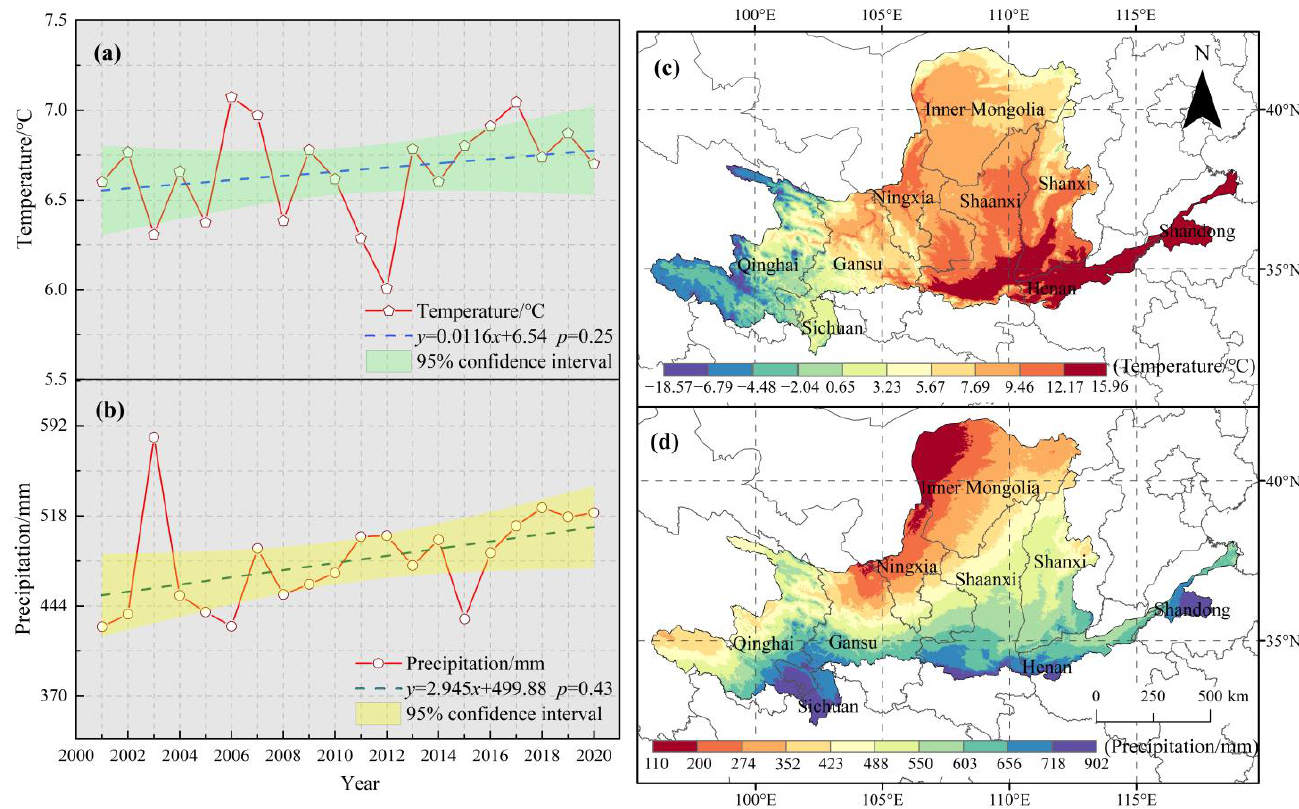
Figure 7. Trends and spatial distribution of temperature and precipitation in the YRB from 2001 to 2020: ( a ) trends of average temperature, ( b ) trends of total precipitation, ( c ) spatial distribution of temperature, and ( d ) spatial distribution of precipitation.